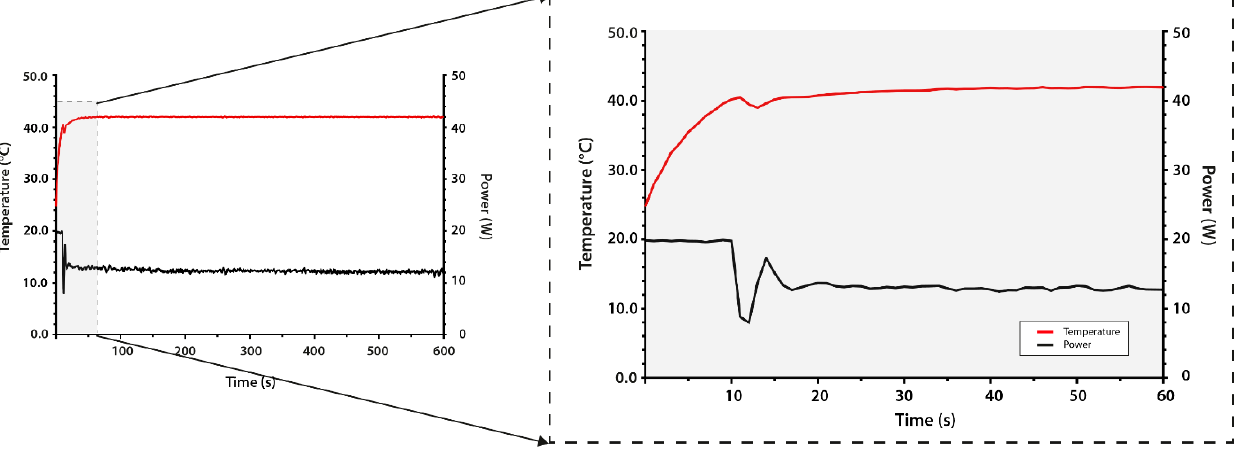
Figure 14. Temperature and power as a function of exposure time using the directional microwave hyperthermia device. The insert demonstrates the build-in feedback loop; upon reaching a Δ T < 2.0 °C from the target temperature (Ttarget, 42.0 °C), the power decreased. This subsequently led to a gradual increase to the Ttarget.